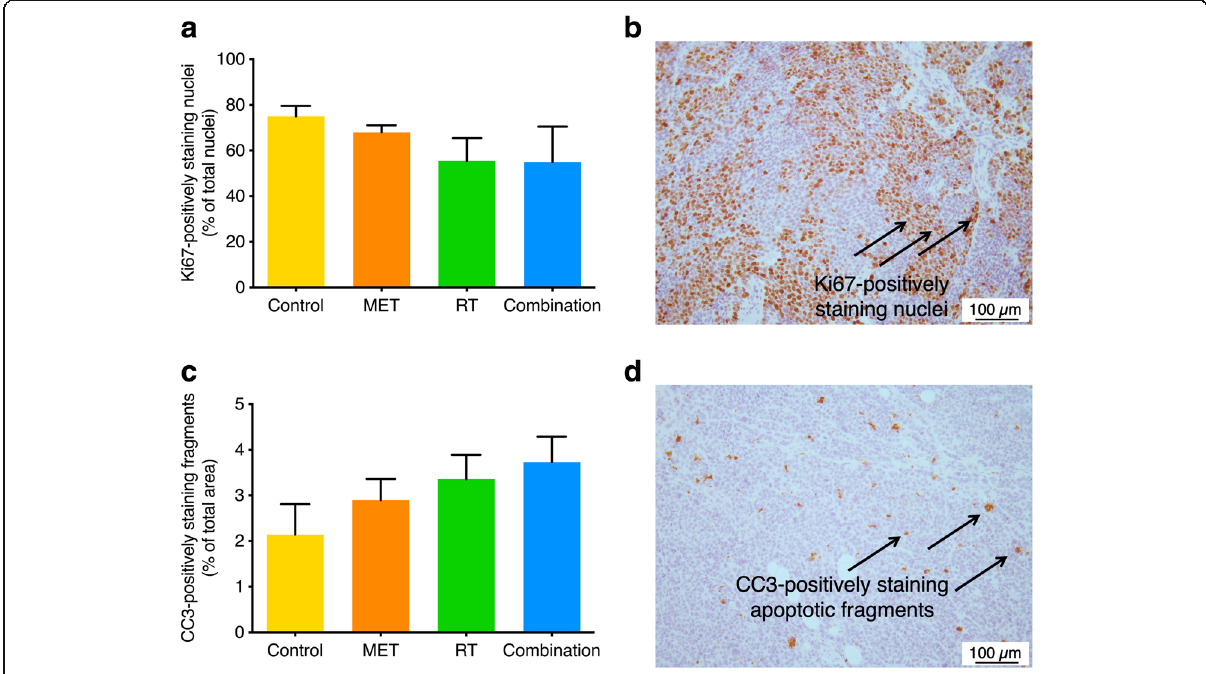
Fig. 4 Ex vivo parameters at time-of-sacrifice (i.e., a tumor volume of 1500 mm 3 ). a Proliferation as assessed by the percentage of Ki67-positive nuclei. b Representative Ki67-stained tumor tissue of a metformin (MET)-treated animal. Arrows indicate Ki67-positively staining nuclei. c Apoptosis as assessed by the percentage of cleaved caspase-3 (CC3)-positive fragments. d Representative CC3-stained tumor tissue of a metformin-treated animal. Arrows indicate CC3-positively staining apoptotic fragments. Statistical significance was not reached. RT,